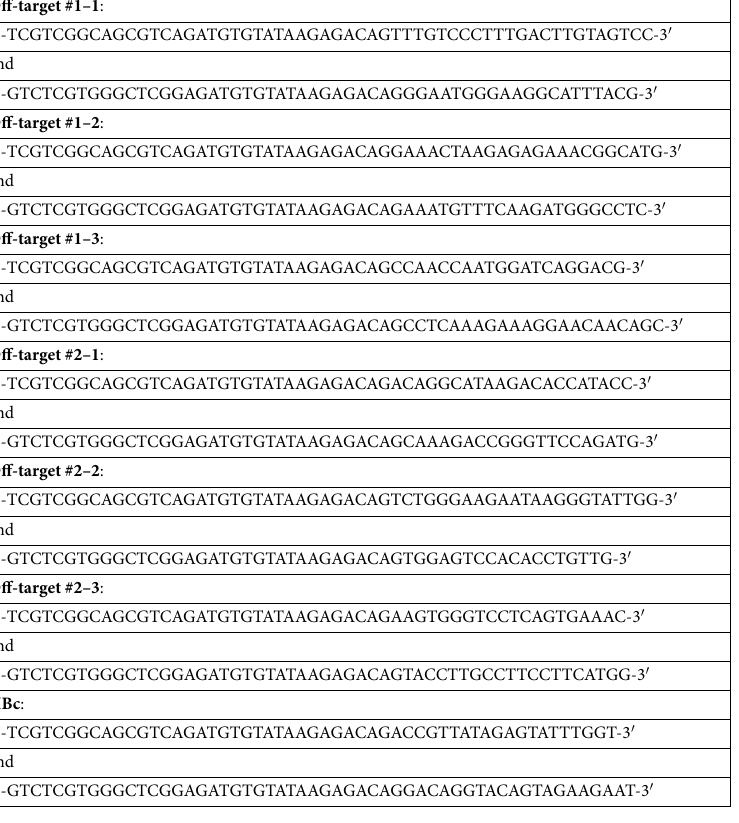
Table 3. The primers used for the detection of the sequences of the possible off-target sites and HBV